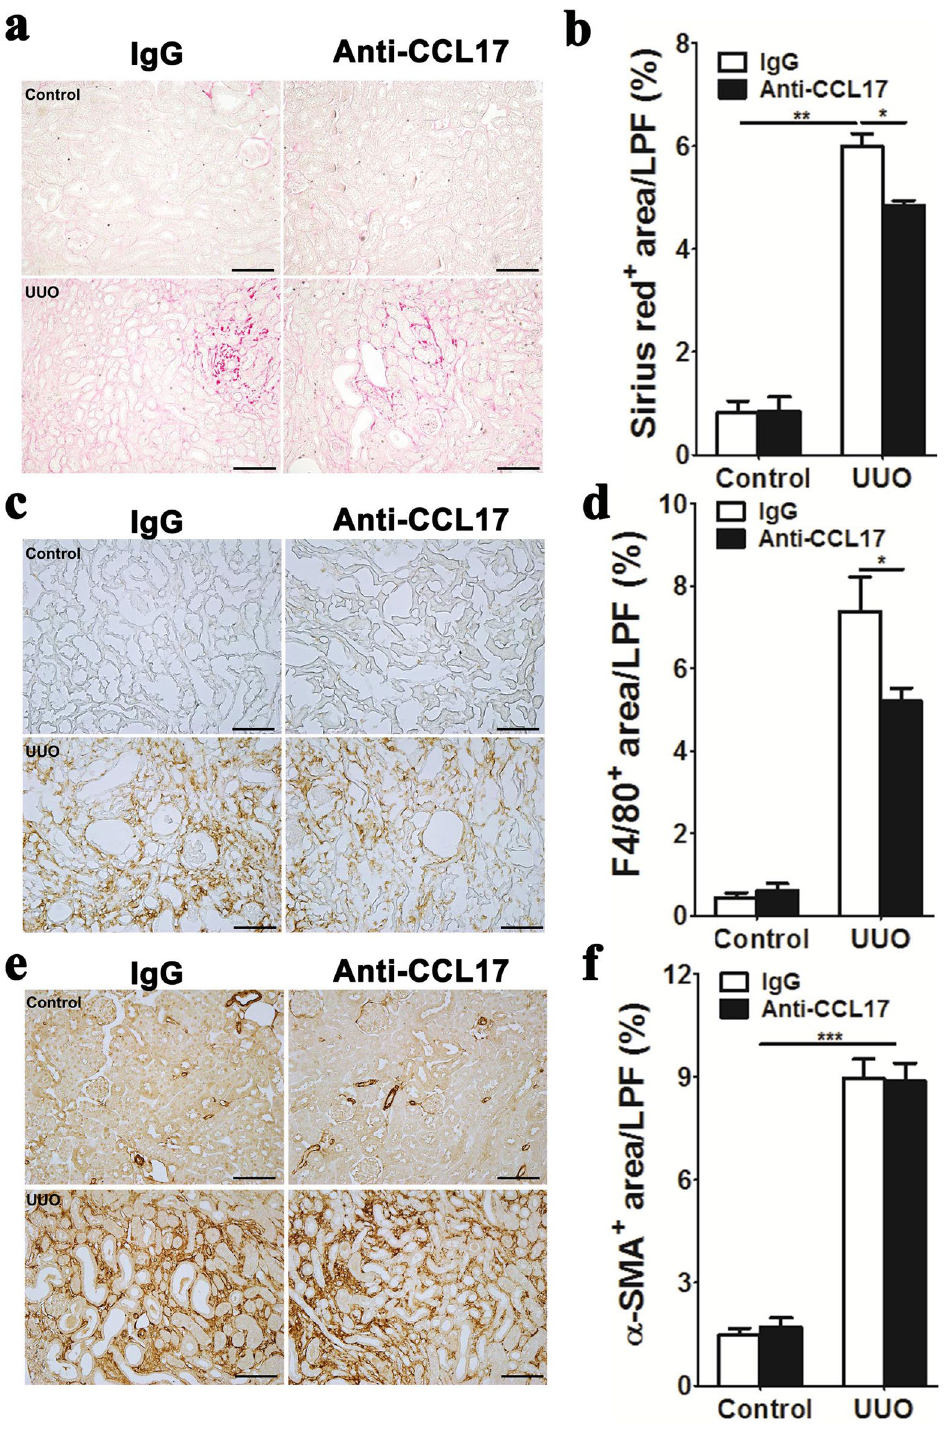
Figure 4. Anti-CCL17 antibody administration attenuated murine obstructive renal fibrosis. ( a ) Representative images of picrosirius red staining in control and UUO kidneys on day 10 after surgery in mice administered with anti-CCL17 antibody or control IgG. ( b ) Quantification of Sirius red + collagen fibrils on LPF images of kidney sections. (c) Representative images of F4/80 immunostaining for macrophages in control and UUO kidneys on day 10 after surgery. ( d ) Quantification of F4/80 + areas on LPF images of kidney sections. ( e ) Representative images of αSMA immunostaining for myofibroblasts in control and UUO kidneys on day 10 after surgery. ( f ) Quantification of αSMA + areas on LPF images of kidney sections. The original magnification of representative images was × 100 in ( a , c , e ) and the LPF images of kidney sections were taken at 100 × magnification in ( b , d , f ). Scale bar, 100 μm. Data are expressed as means ± standard errors of the mean. n = 6. * P < 0.05, ** P < 0.01 and *** P < 0.001 by one-way ANOVA with post hoc Tukey’s multiple comparisons